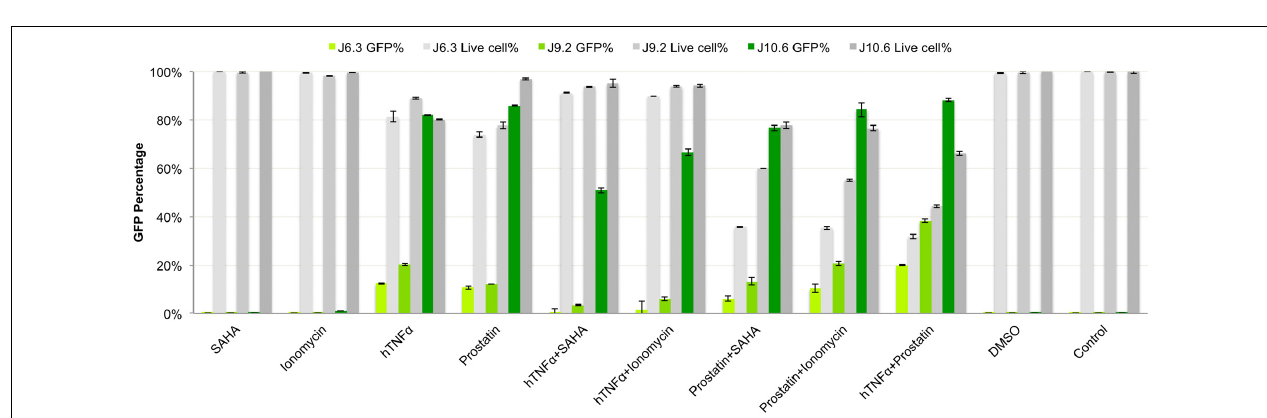
FIGURE 1 | Study designing and experimental plan: Schematic representation of experimental plan for RNAflow and RNAscope.